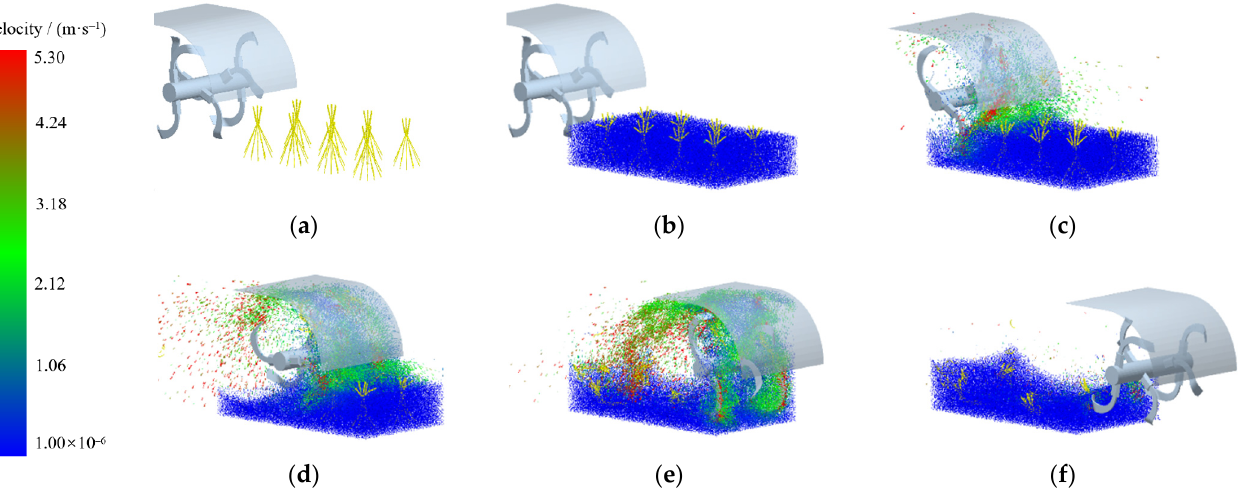
Figure 12. Simulation process of reverse rotary tillage for Cyperus esculentus harvesting. ( a ) 0.5 s; ( b ) 1 s; ( c ) 2 s; ( d ) 4.5 s; ( e ) 6.4 s; ( f ) 8.7 s.